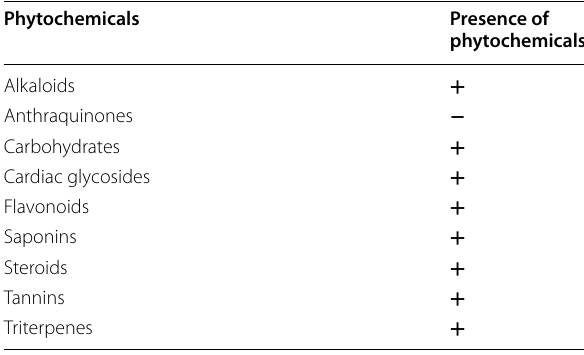
Table 1 Phytochemical screening of aqueous stem bark